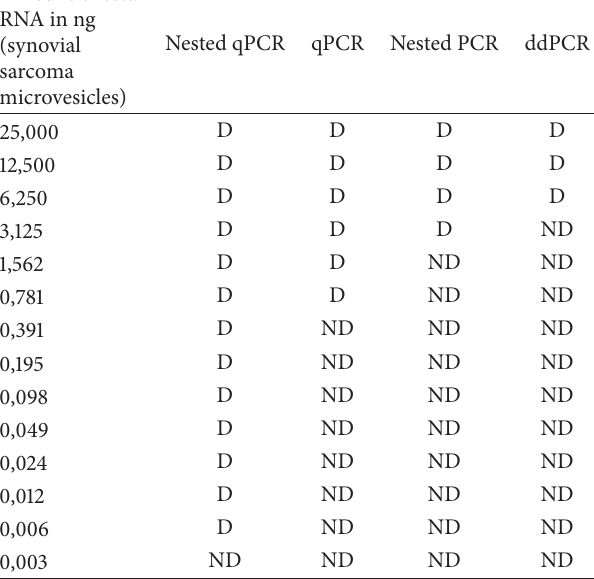
Table 2: Comparison of sensitivity of nested PCR, qPCR, nested PCR, and ddPCR at detection of SYT-SSX fusion gene in 1273/99 synovial sarcoma microvesicles. D: detected, ND: not